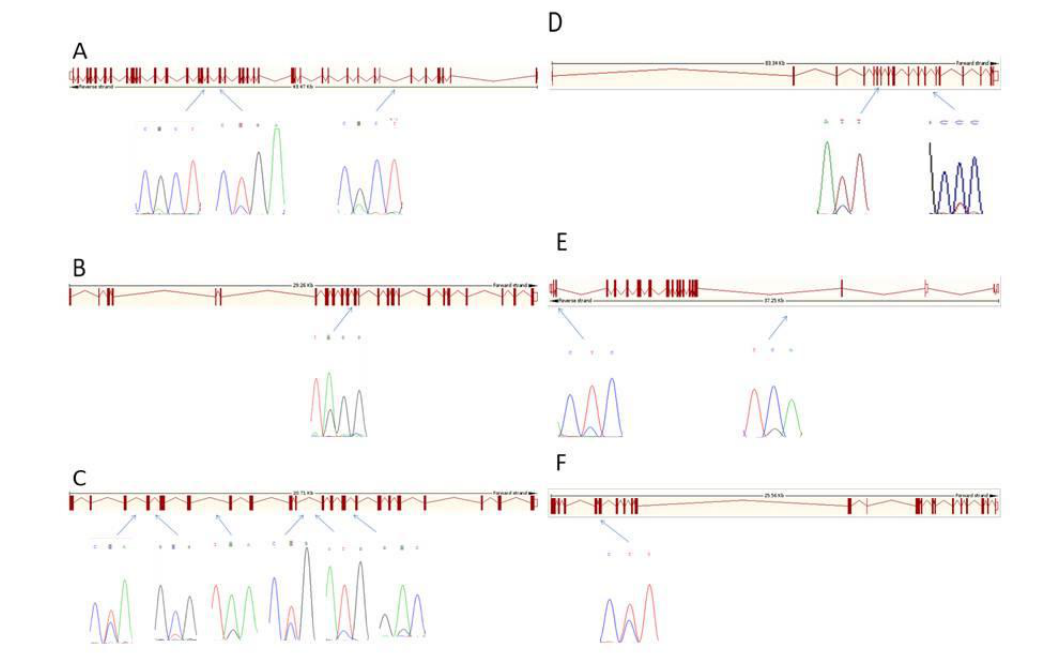
Figure 1. Position of single nucleotide polymorphisms identified in (A) DNMT1 , (B) DNMT3a , (C) DNMT3b , (D) Ago2 , (E) HDAC5 , and (F) CAPN1 . DNMT , DNA (cytosine-5-)-methyltransferase; Ago , argonaute RISC catalytic component; HDAC 5, histone deacetylase 5; CAPN1 , calpain 1, (mu/I) large